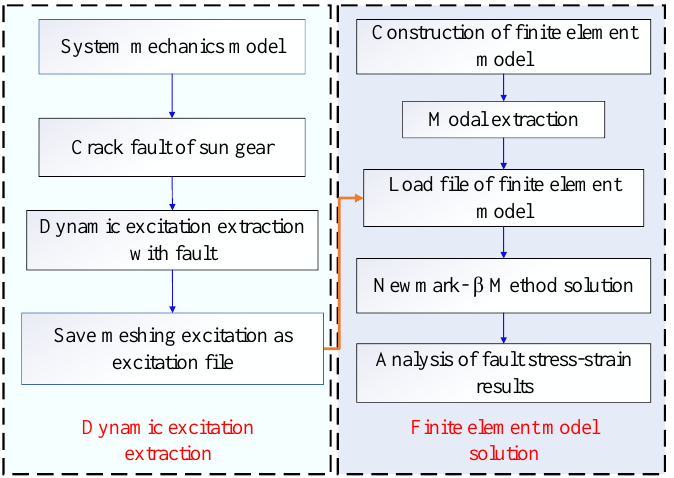
Figure 13. Flow chart of the dynamic strain solution of the inner ring under the crack fault of the solar wheel.